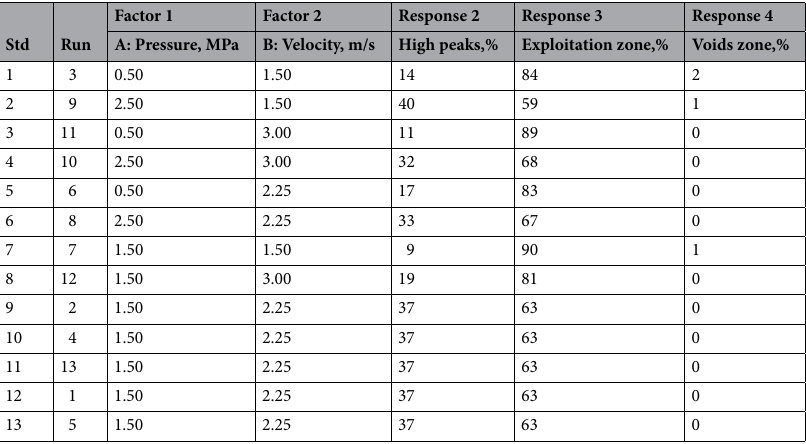
Table 9. Experimental CCD showing Abbott Firestone zones of 0.16C QAM f steel.